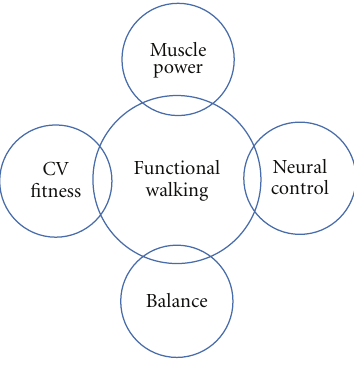
Figure 3: Walking performance is likely composed of four main physical components (cardiorespiratory fitness, strength, motor control, and dynamic balance) with additional unknown contribut- ing factors. The degree of contribution and overlap is unknown at this time and part of the individualized nature of poststroke locomotor